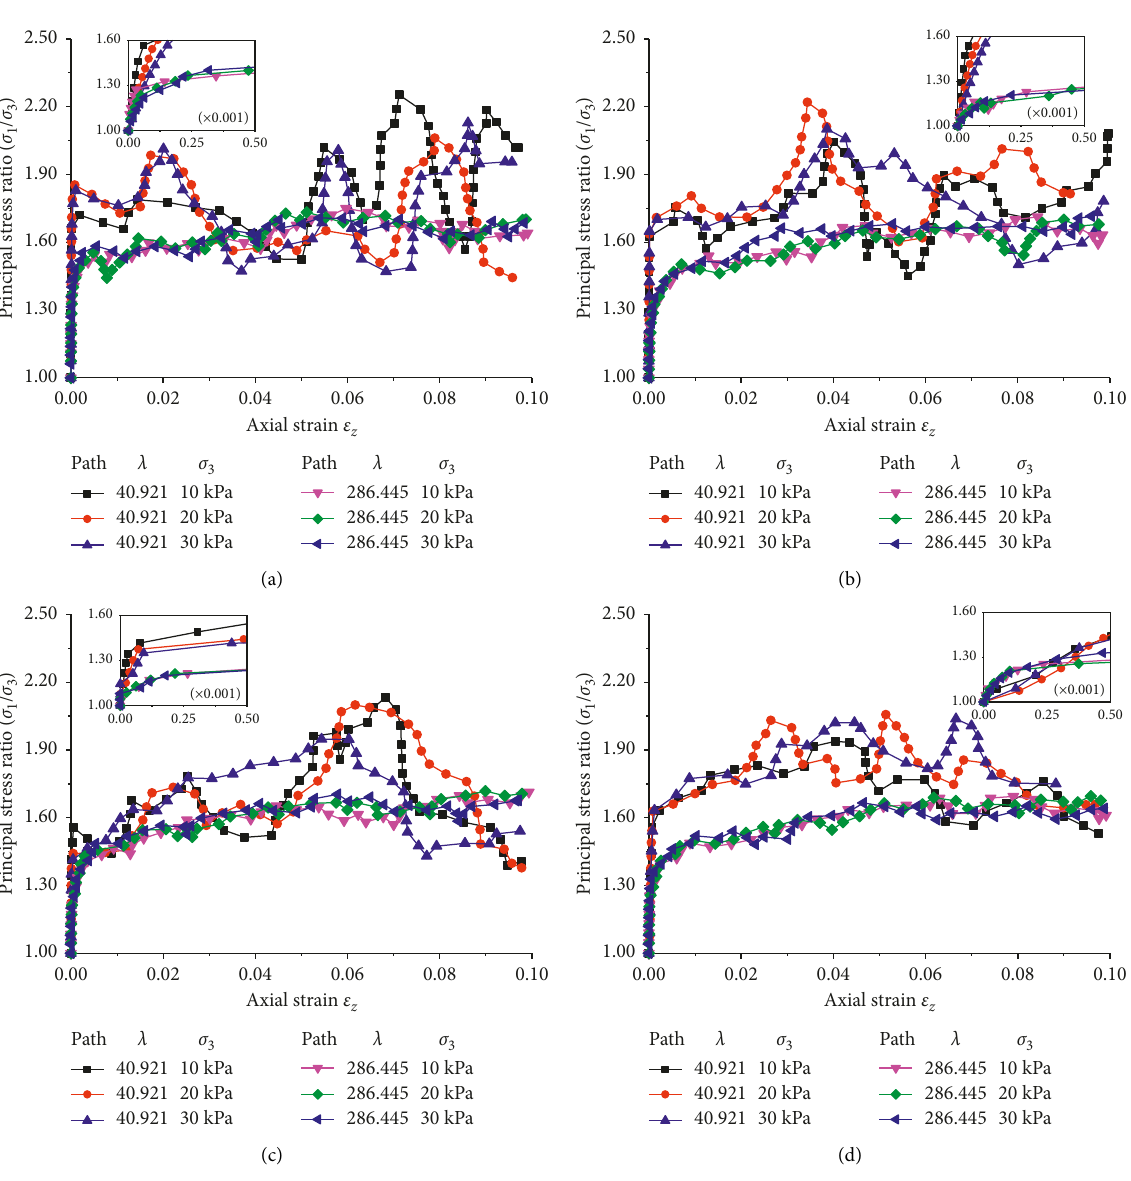
Figure 5: Influence of size effect on principal stress ratio-axial strain relationship of RVEs at 0g gravity. (a) RVEs with various heights at 0g. (b) RVEs with various particle sizes at 0g. (c) RVEs with various heights at 5 g. (d) RVEs with various particle sizes at